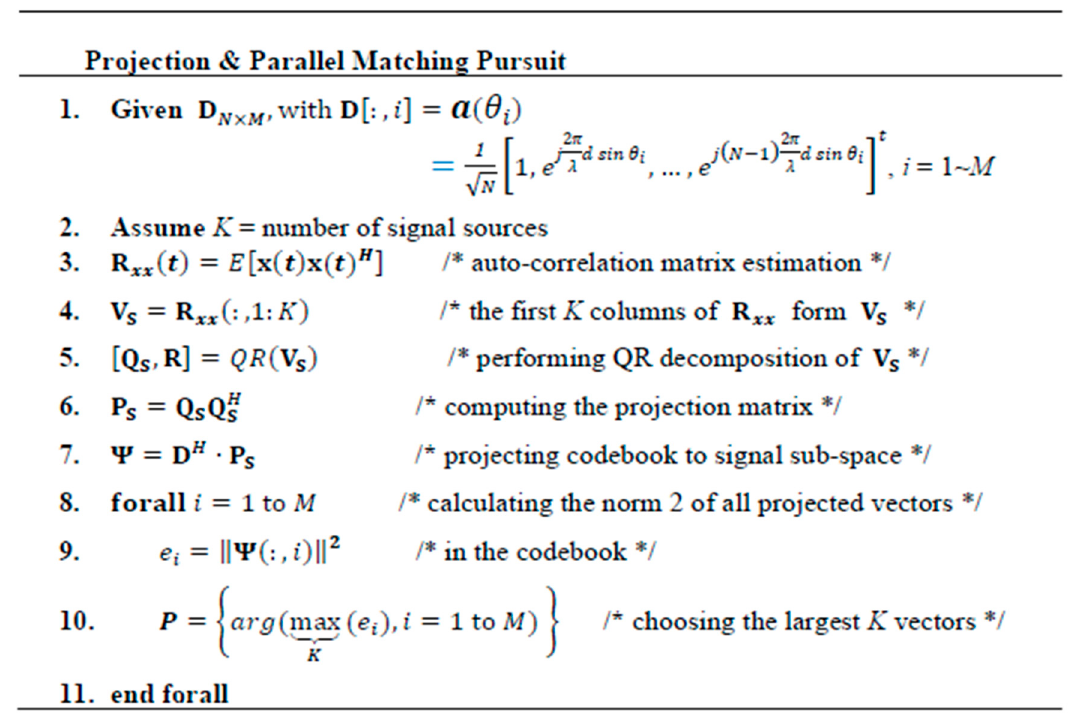
Figure 3. Pseudo code of the projection and parallel matching pursuit based DoA estimation algorithm.